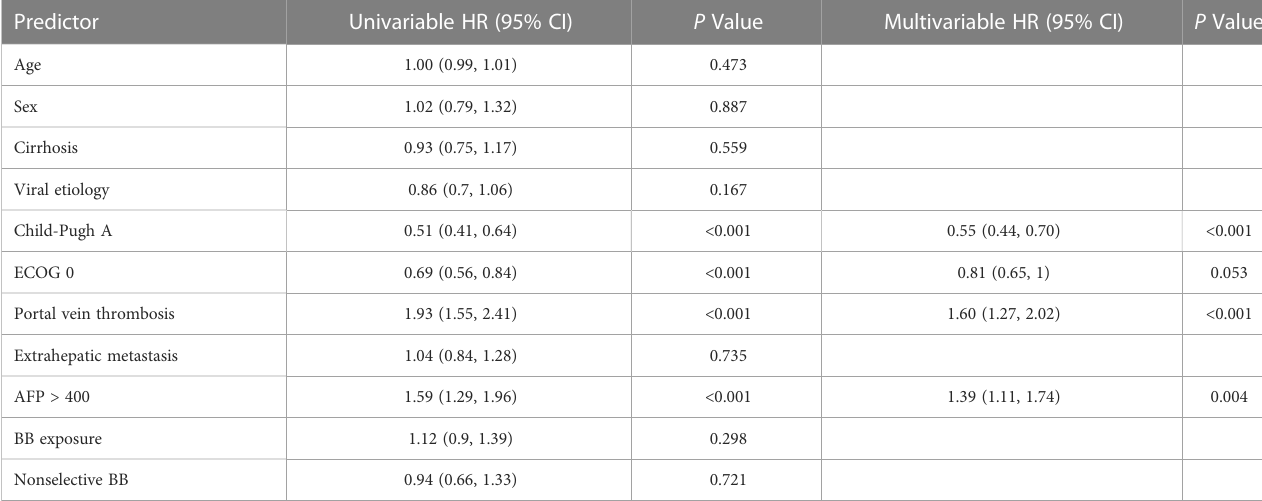
TABLE 3 Univariable and multivariable Cox proportional hazard models for overall survival.